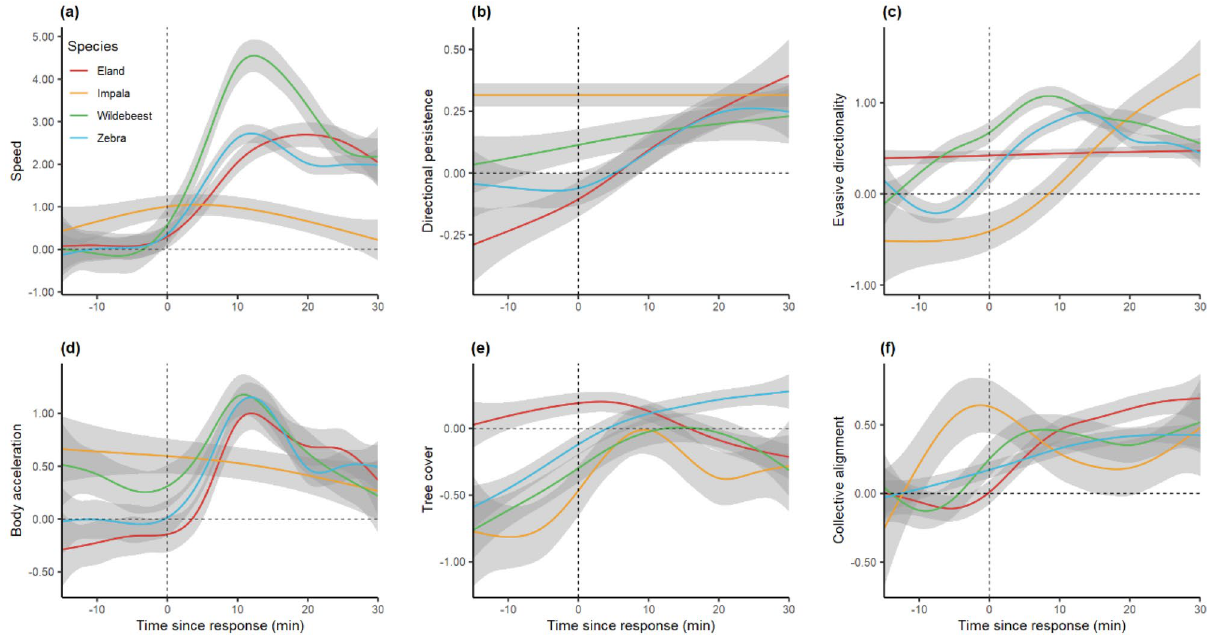
Figure 2. A sample of the 2117 computed animal movement features characterizing the sentinels’ behavior near experimental intrusions, shown here as function of the time since the annotated start of their response behavior (i.e., ‘flight’ and ‘regroup’ as described in the main text). All y-axes show standardized values (zero-mean and unit-variance when undisturbed), and the shaded area around each line (i.e., sentinel species) depicts pointwise 95% CI of a General Additive Model. When encountering the experimental intrusions, the sentinels moved faster ( a ), straighter ( b ), away from the intrusion ( c ), and with higher body acceleration ( d ). The sentinel species that prefer more grass-dominated habitats (i.e., lower tree cover) tended to move towards areas with higher tree cover ( e ) and thus lower habitat suitability. Moreover, encountering the intrusions induced more aligned collective movement ( f